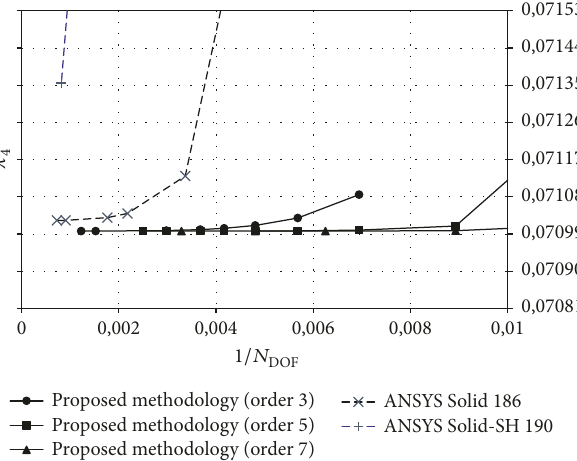
̂𝜆 1/𝑁 ℎ -convergence). 3 versus DOF (